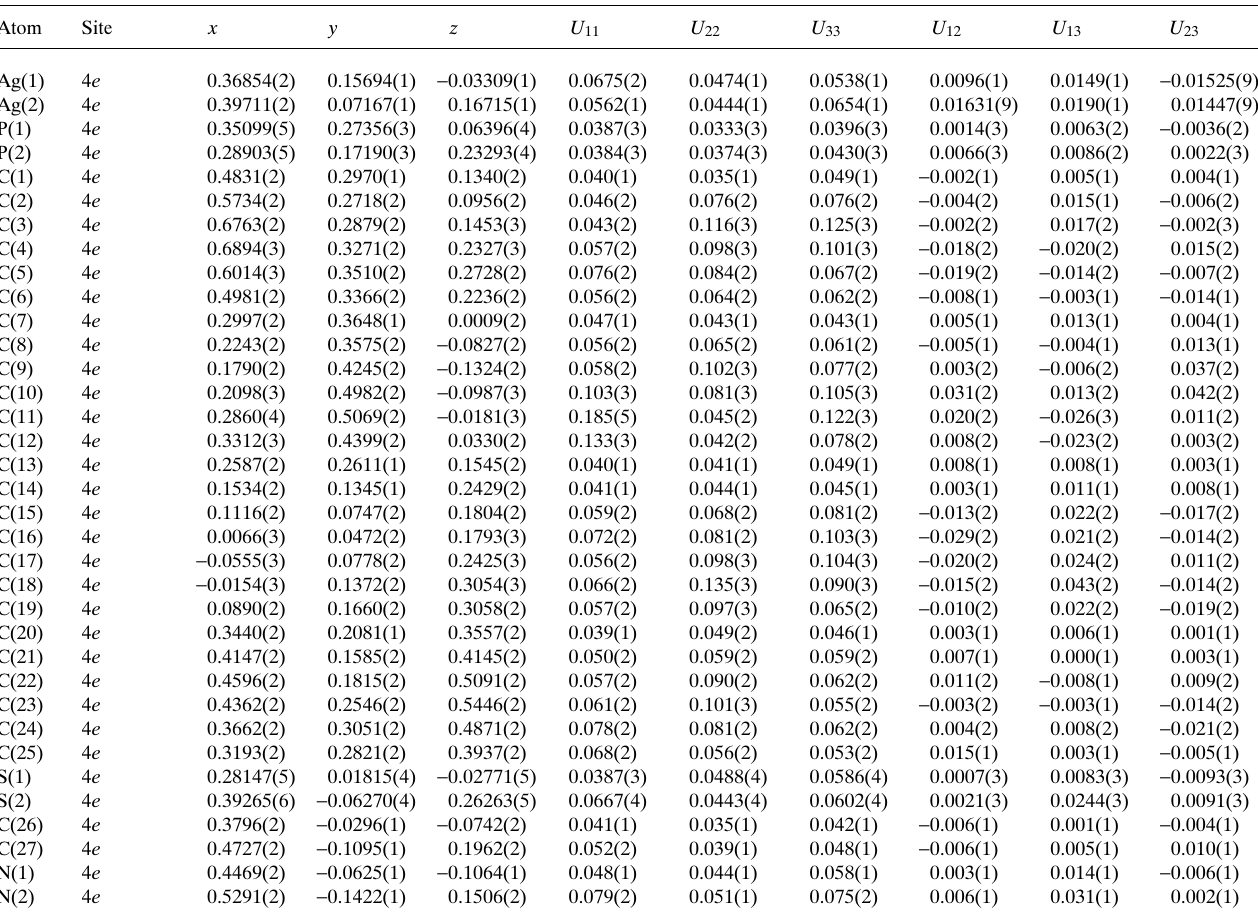
Table 3. Atomic coordinates and displacement parameters (in Å 2 ) .